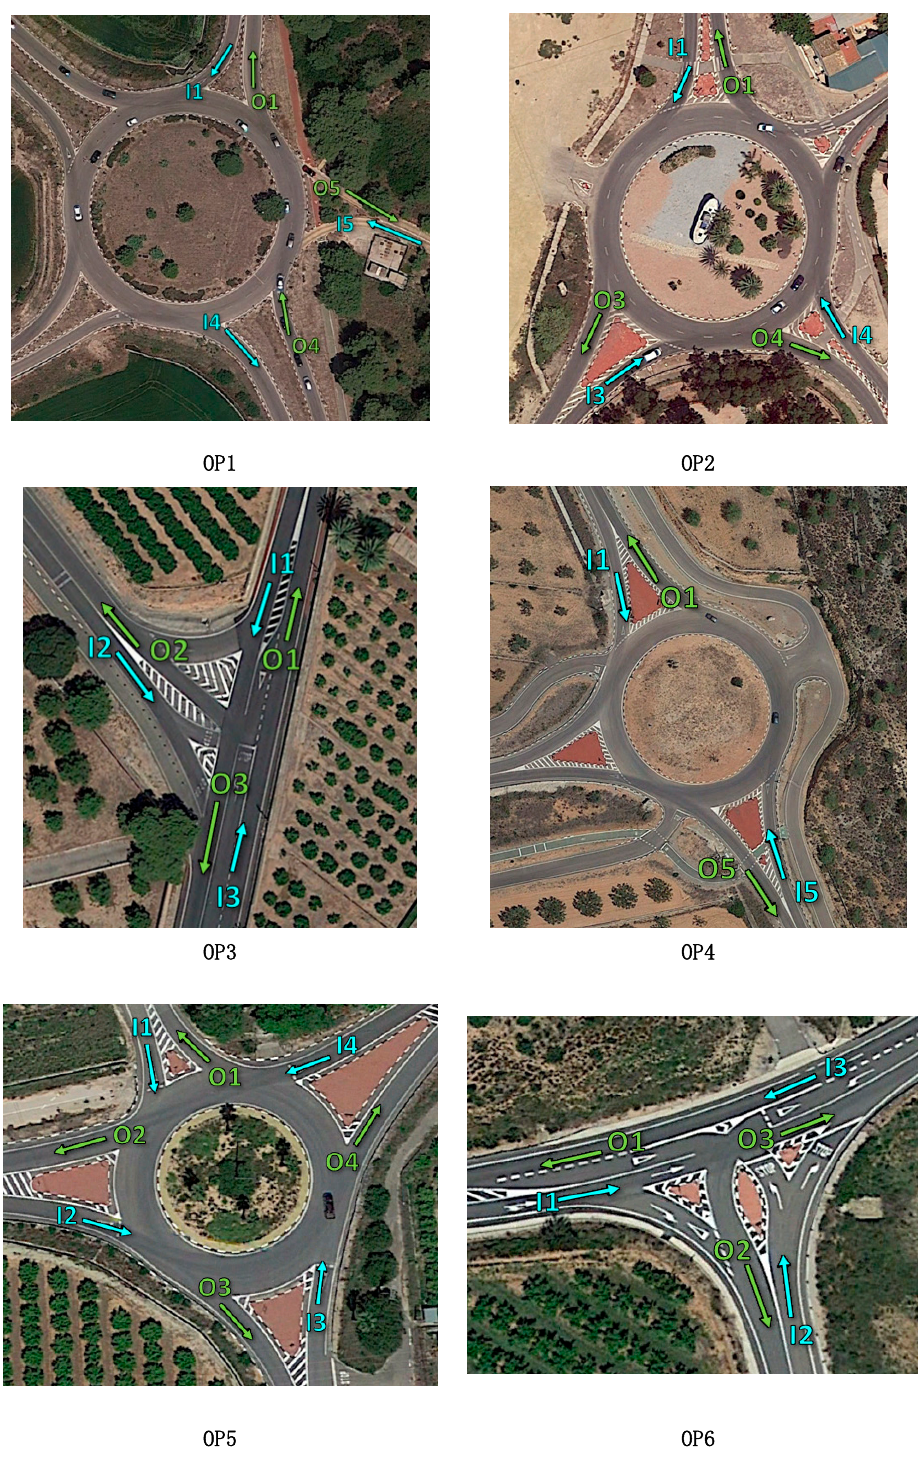
Figure 3. Observation points and segments under analysis.